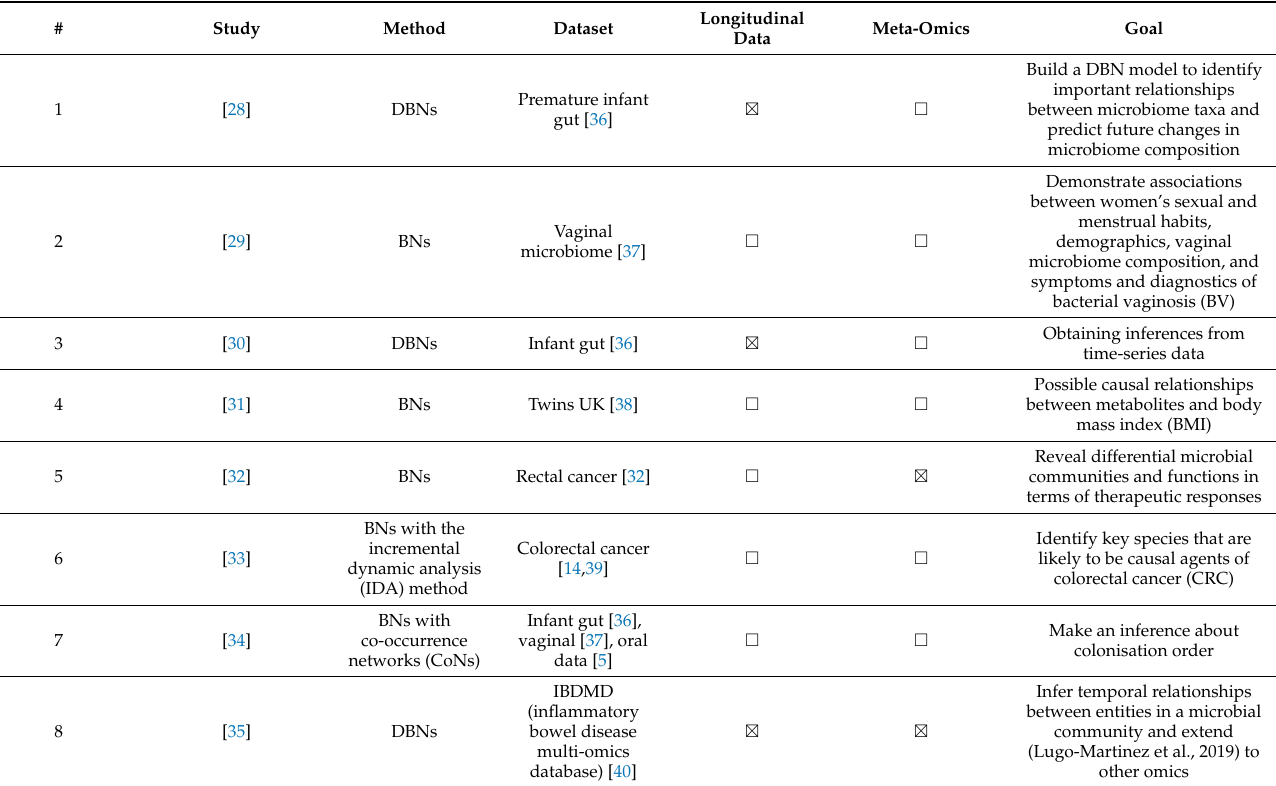
Table 1. State of the art of BNs models applied to human microbiome datasets. Studies appear in chronological